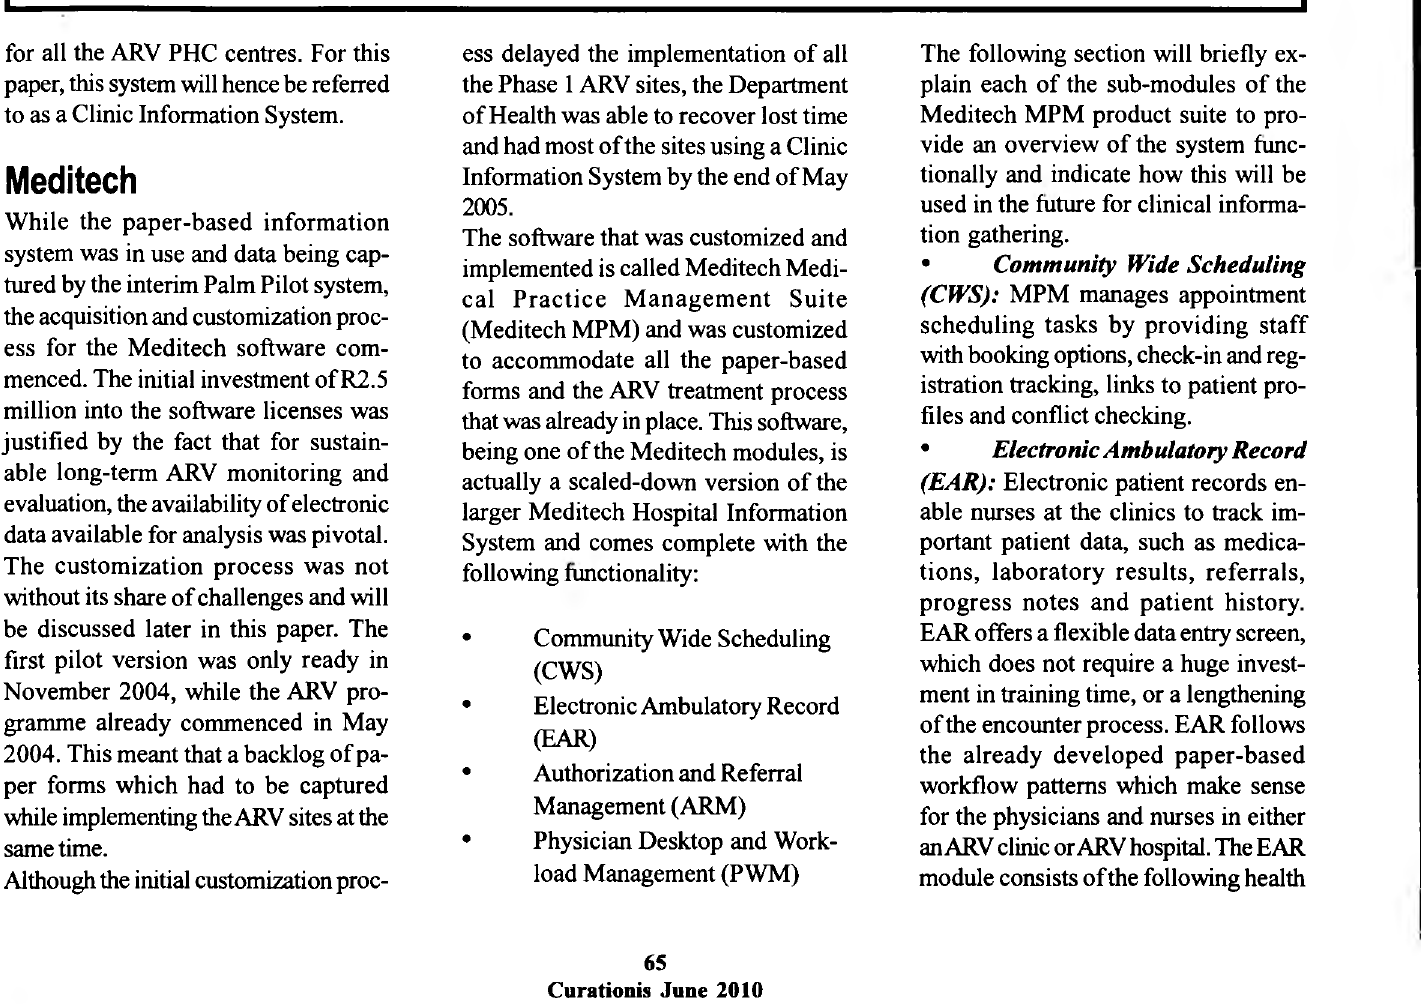
Figure 2: Model of the ARV Information